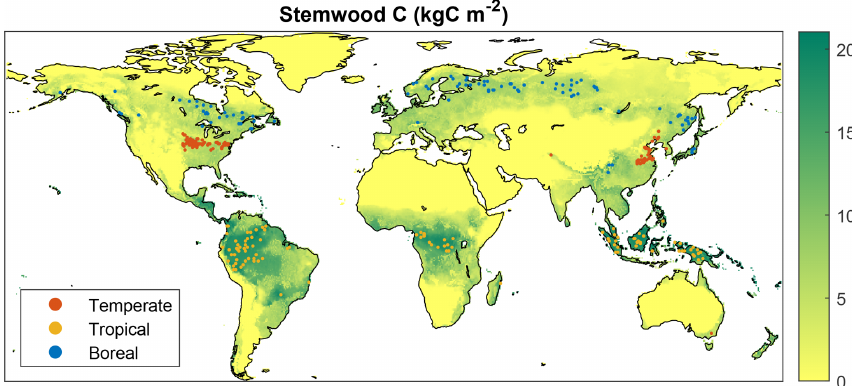
Figure 1. Location of the grid cells included in calibration simulations (100 per FPFT). The map shows simulated stemwood C (kgCm − 2 ) for a simulation with potential natural vegetation.